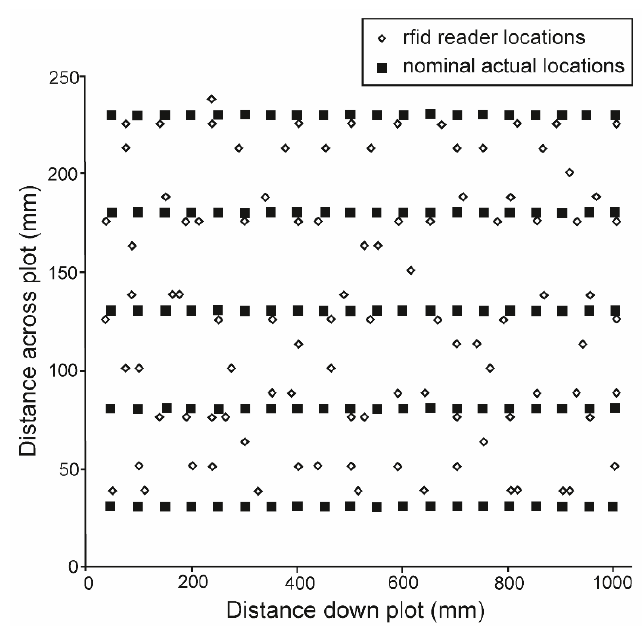
Figure 7. Difference between RFID nominal locations and those obtained from the multiple observations by the remote reader.